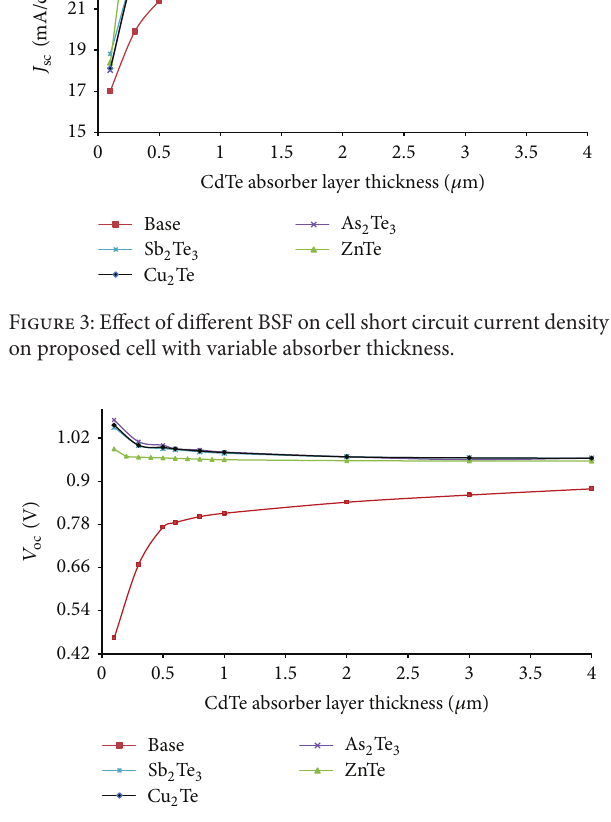
Figure 4: Effect of different BSF on cell open circuit voltage on proposed cell with variable absorber